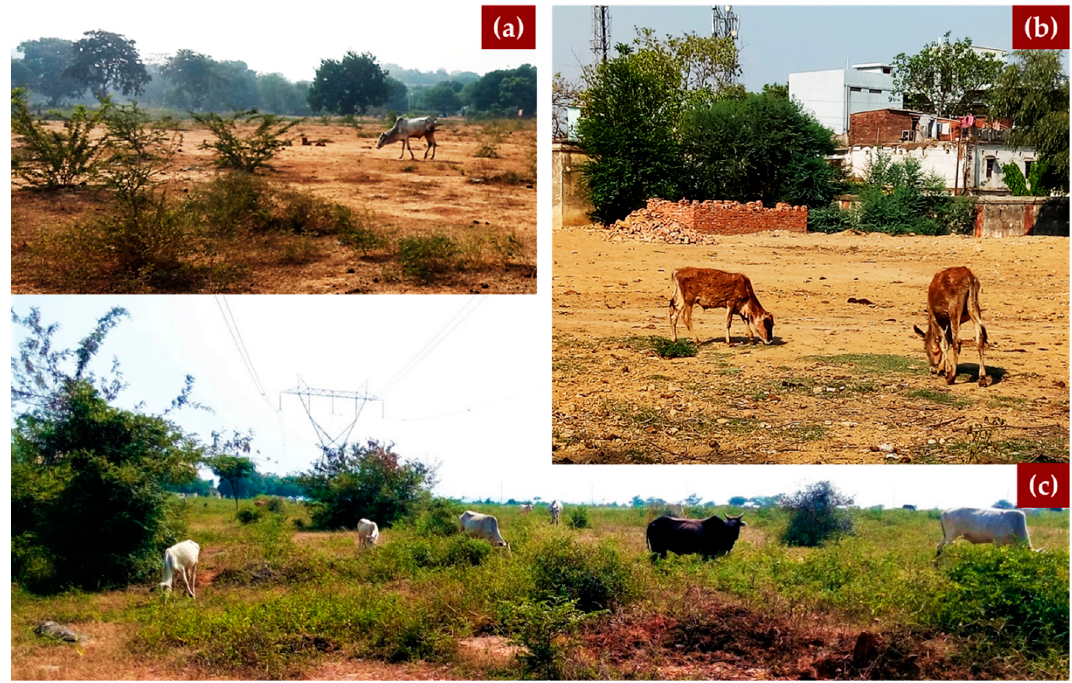
Figure 5. The effect of P. juliflora invasion on livestock. (a–b) the species has invaded into the nearby grazing land and reduce the fodder availability (c ) than the control site by displacing local species.